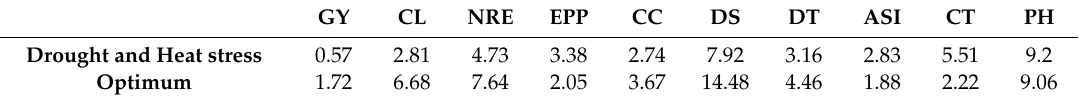
Table 10. Ratios of GCA:SCA mean squares for yield, yield components and other morpho-agronomic traits under optimum as well as combined drought and heat-stressed